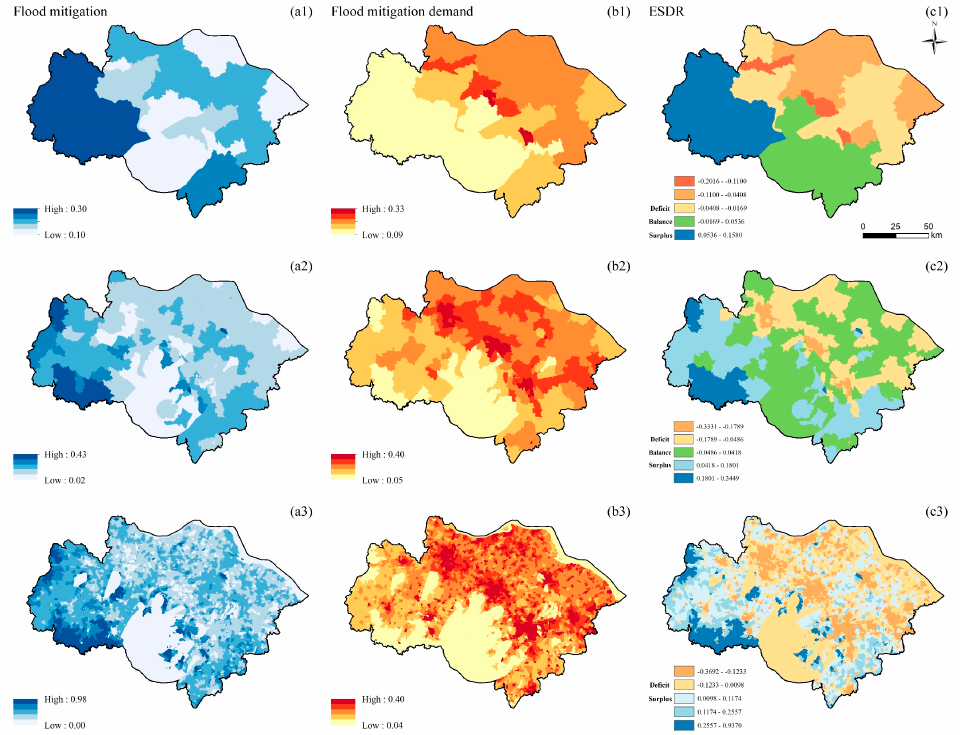
Figure 5. Spatial distribution of FM (unit: dimensionless, the value is between 0–1) at the county ( a1 , b1 , c1 ), township ( a2 , b2 , c2 ), and village ( a3 , b3 , c3 ) scales; supply of FM ( a1 – a3 ); demand for FM ( b1 – b3 ); ESDR ( c1 – c3 ).